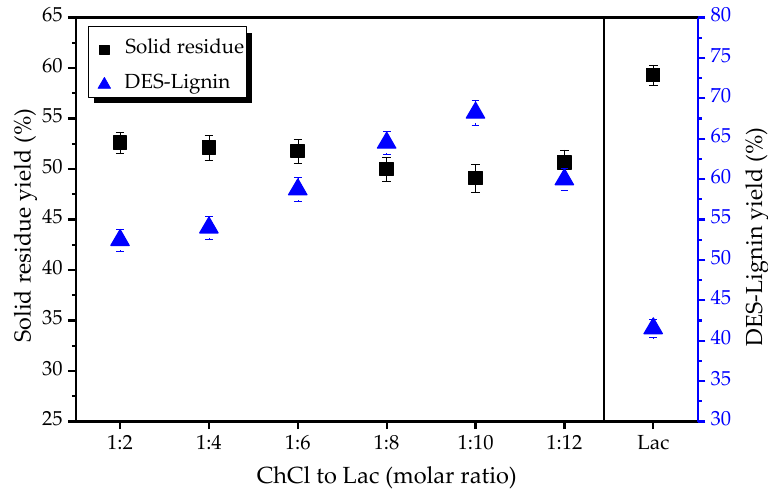
Figure 2. Effect of different mole ratio of choline chloride (ChCl) to lactic acid (Lac), as well as Lac which was not formed DES with ChCl on the solid residue yield and DES-Lignin yield. The treatment conditions: temperature, 120 °C; time: 6 h.